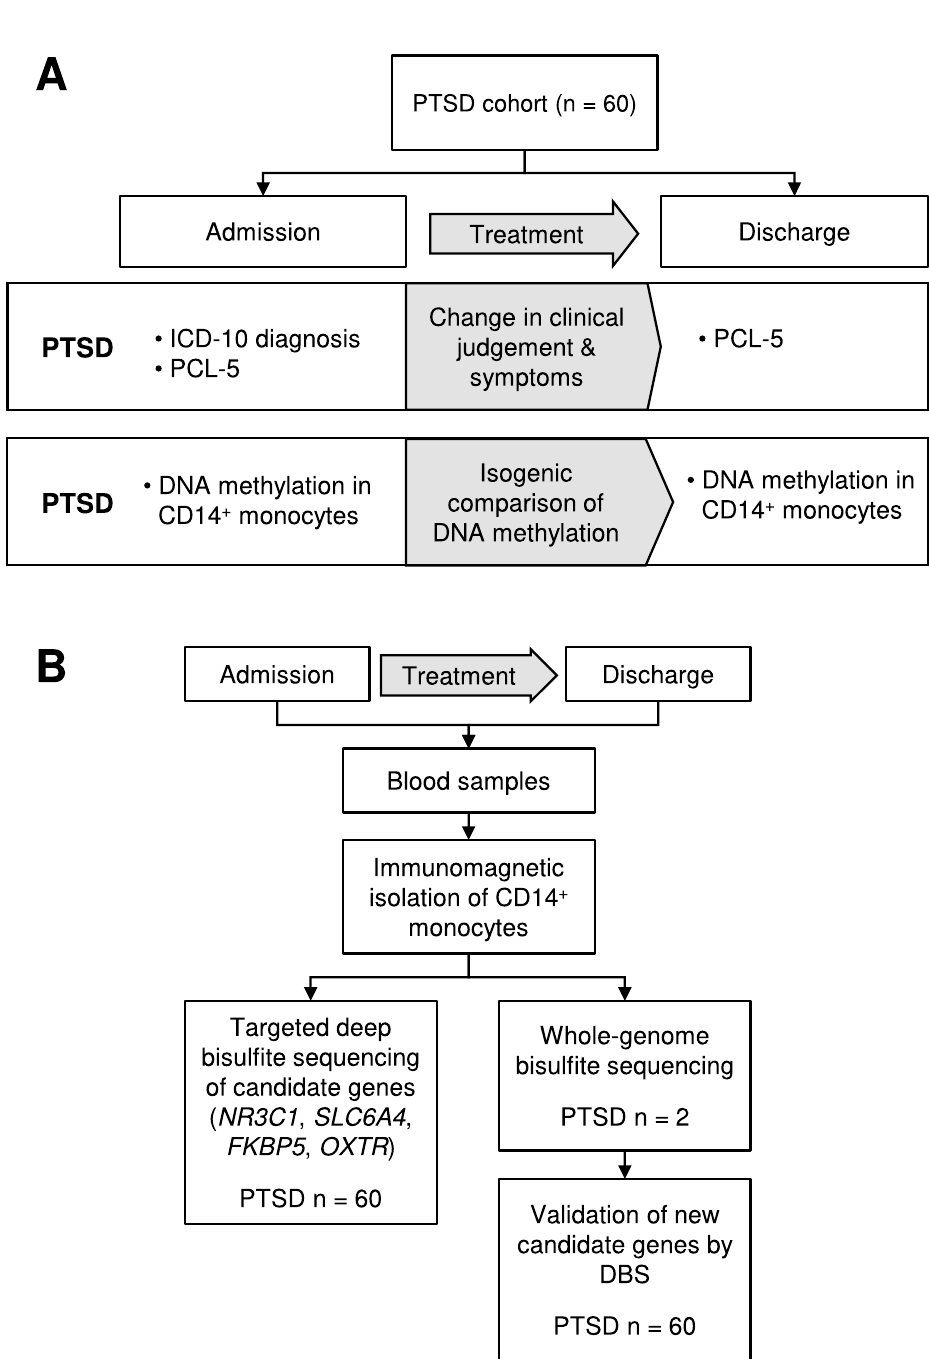
Figure 4. Overview of the study design. ( A ) Study design indicating diagnostic instruments and questionnaires and sample collection at admission and discharge; ( B ) Flow chart of the laboratory analysis procedure after sample